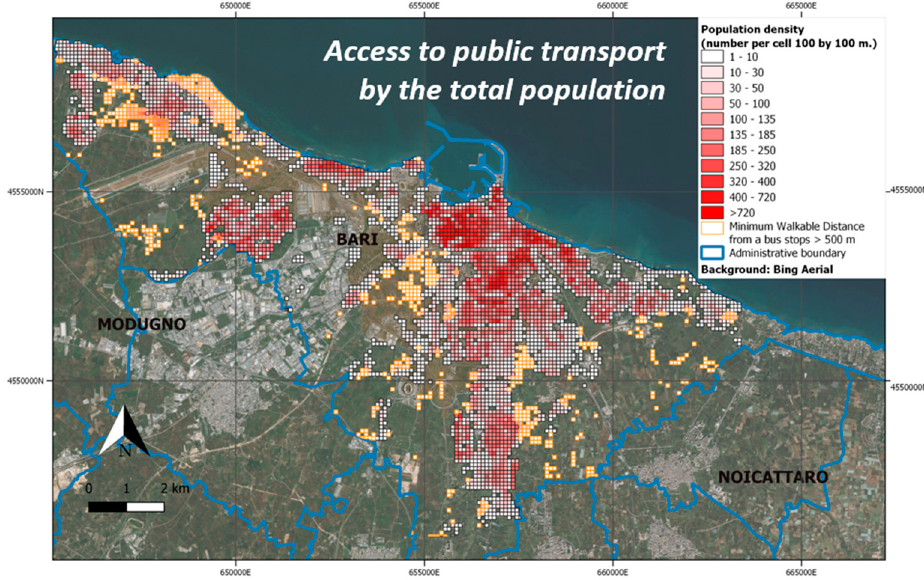
Figure 24. SDG 11.2.1 Indicator: The cells in orange identify people that do not have convenient access to public transport as a proportion of the total population (including migrant component).